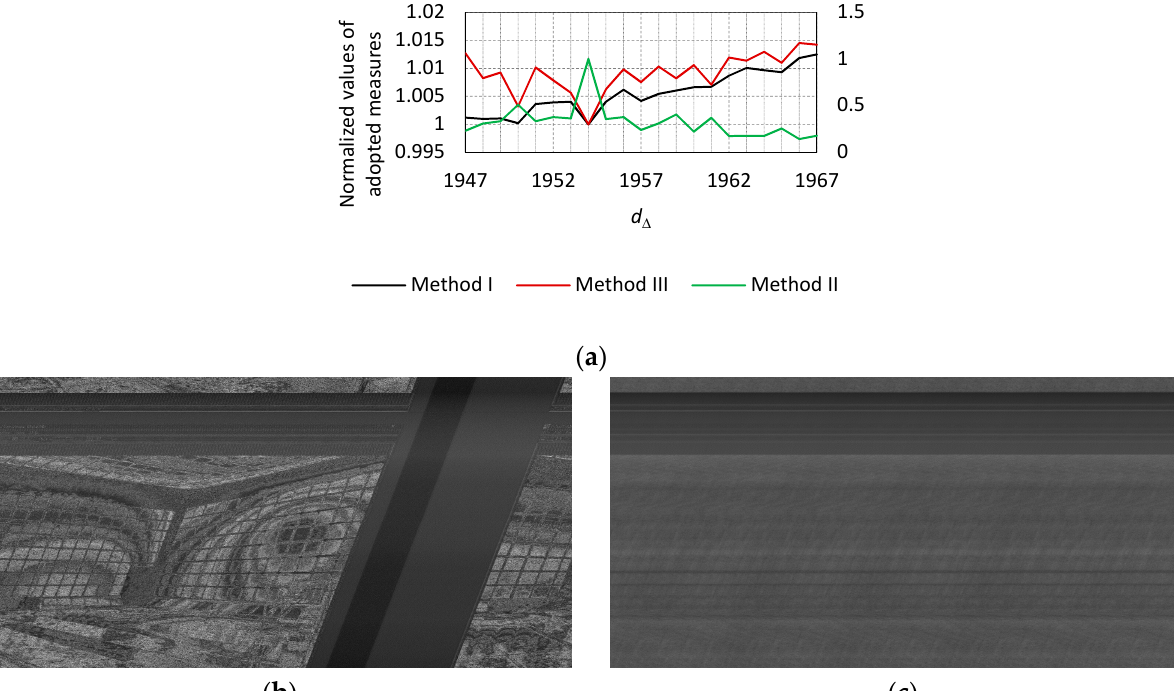
Figure 18. ( a ) The normalized values of the adopted measures (method I, II and III) calculated in domain of image line length d ∆ for the accuracy ∆ = 1.0 (for the original image shown in Figure 7b) and images reconstructed on the basis of the recorded revealing emission signals at frequency f o = 1334 MHz (receiving bandwidth BW = 50 MHz, accuracy ∆ = 1.0), ( b ) for estimated line length d ∆ = 1954.00000, multiple of image summation Sum MTL = 1 and ( c ) for estimated line length d ∆ = 1954.00000, image summation multiple Sum MTL = 30 —the source of revealing signal emission—display monitor, HDMI standard.